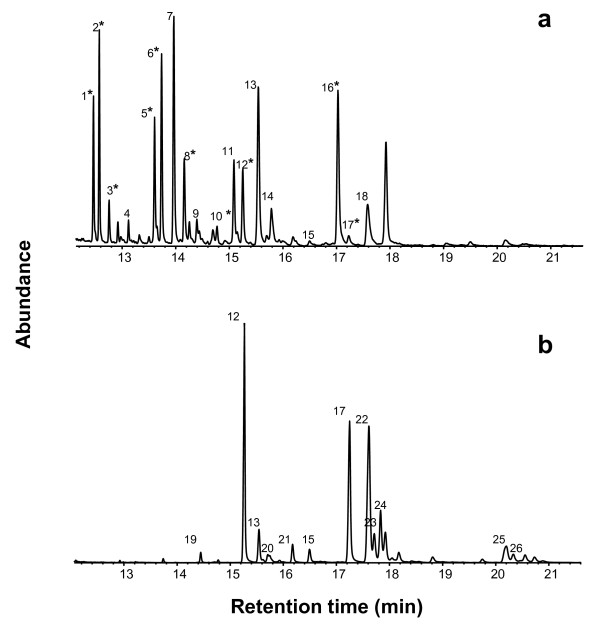
Cuticular hydrocarbon profiles of Monomorium pharaonis (a) and M. destructor (b). The numbers on the peaks mark the identified hydrocarbons: (1*) C25:1; (2*) C25; (3*) 9-,11-,13-MeC25; (4) C26; (5*) C27:1; (6*) C27; (7) 9-,11-,13-MeC27; (8*) 11,15-diMeC27; (9) 3-MeC27; (10*) 3,11-diMeC27; (11) C29:1; (12*) C29; (13) 11-,13-,15-MeC29; (14) 11,15-diMeC29; (15) 3,11-diMeC29; (16*) C31:1; (17*) C31; (18) 11-,13-,15-MeC31; (19) C28; (20) 5-MeC29; (21) C30; (22) 11-,13-MeC31; (23) 7-MeC31; (24) 5-MeC31; (25) 11-,13-MeC33; (26) 7-MeC33. The numbers with an asterisk denote the hydrocarbons that explain most of the variation in the overall principal component analysis, i.e. numerical value of factor loadings > 0.7. Factor loadings for these compounds were: (1) -0.736; (2) -0.835; (3) -0.867; (5) -0.745; (6) -0.885; (8) -0.768; (10) 0.797; (12) -0.751; (16) 0.902; (17) -0.841.